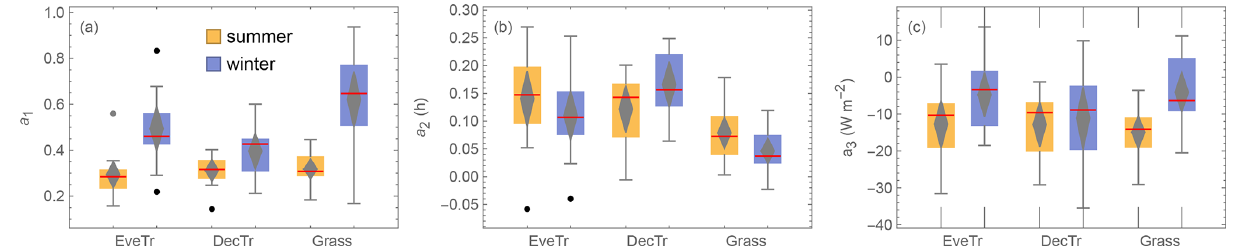
Figure 7. Boxplots showing variability of OHM coefficients between land covers (EveTr, DecTr and Grass) and seasons (summer and winter): (a) a 1 (b) a 2 and (c) a 3 . Boxes (25th and 75th percentiles) and whiskers (5th and 95th percentiles), with median (red line) and mean (middle grey diamond, with 95% confidence level (top and bottom) values, and outliers (dots).